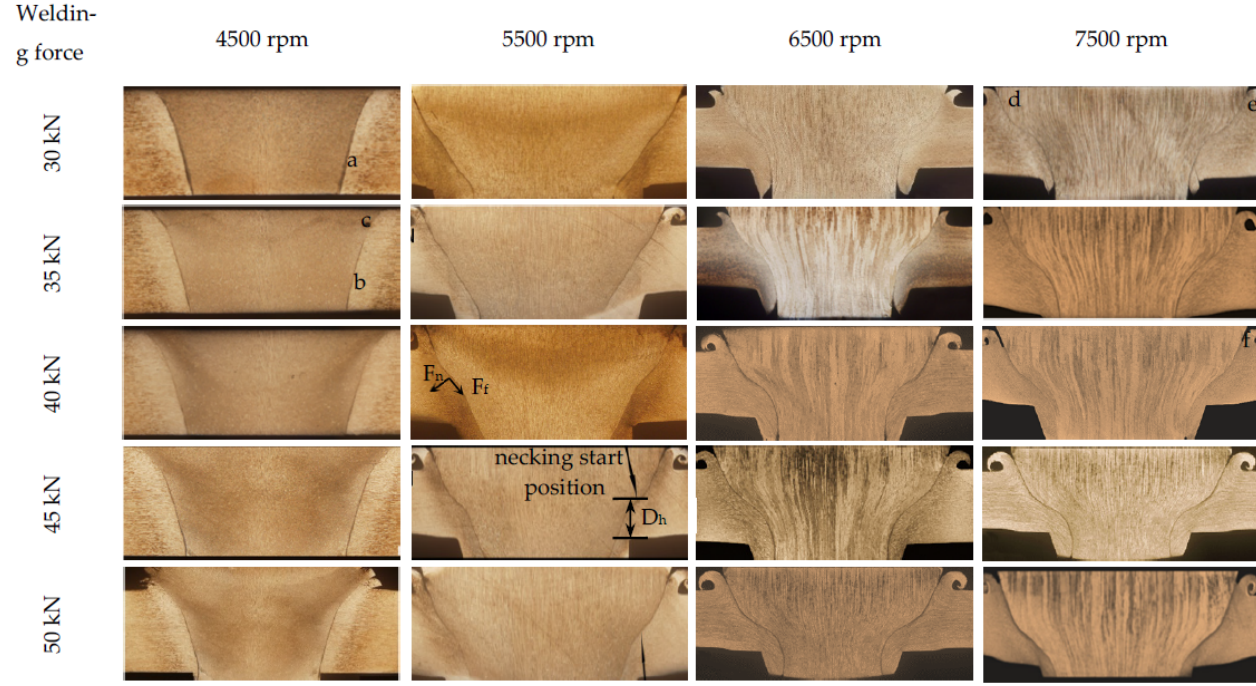
Figure 5. Cross ‐ sectional appearance of FPW joints. Figure 5. Cross-sectional appearance of FPW Table 3. Weld quality of FPW joints.